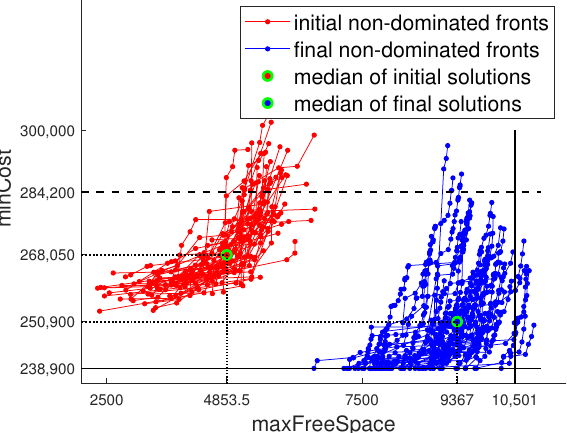
Figure 5. Evolution of non-dominated solutions using MOEA_T_T. Initial (red) and final (blue) sets of non-dominated solutions generated in 100 independent runs are shown. The horizontal dashed line indicates the minCost = cost static value of solutions produced for the data set D A (i.e., without alternative workstations). The vertical solid line indicates the median maxFreeSpace value obtained with single-objective EA on data set D A